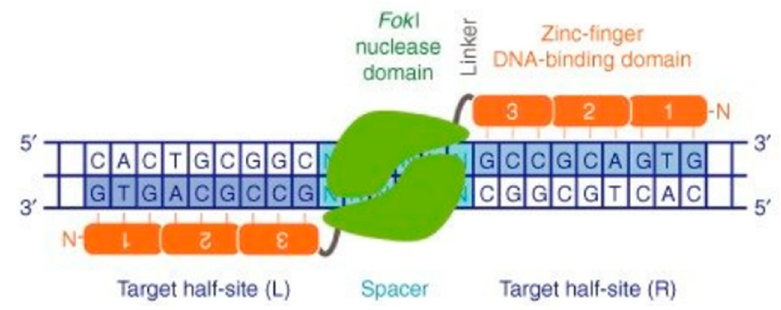
Figure 3. Zinc fi nger nuclease (ZFN)-mediated genome editing [8]. Figure 3. Zinc finger nuclease (ZFN)-mediated genome editing